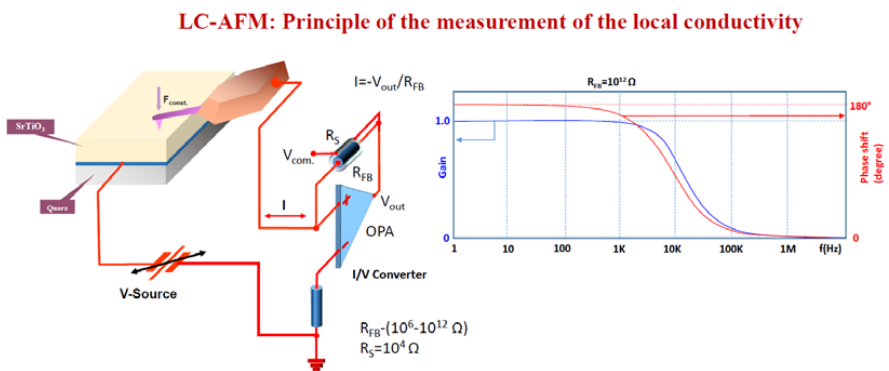
Figure 34. Schematics of the LCAFM method for determining the resistance distribution in the surface layer. An important element of the electronical circuit is the voltage-to-current converter, whose sensibility for current detection of high-ohmic materials should be extremal high (~1–10 fA). Notice: for this ultra-low current the high-ohmic resistor (R FB ) in the feedback of the operation amplifier (OPA) needs an additional compensation of the parasitic capacity (see [224]). Only for this compensated configuration the bandwidth of the system is broad enough (see inset) to scan in “finite time” a surface of crystal with resistance of many hundred teraohms.